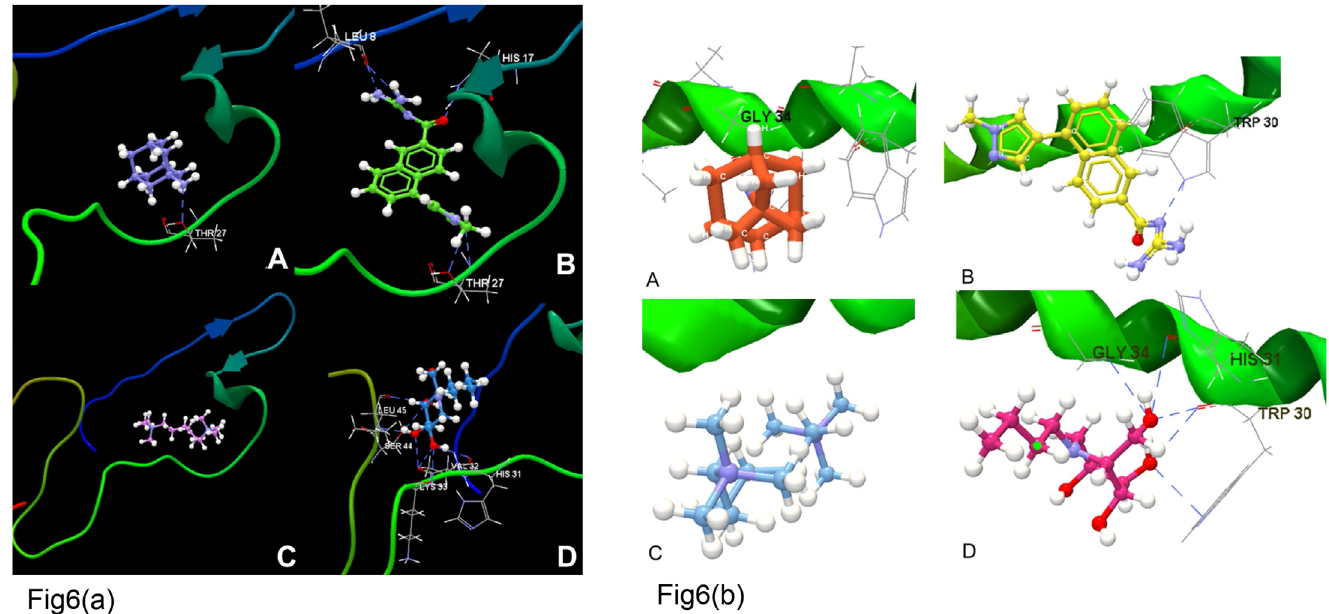
Fig 6. Computational docking study of GT3 p7 model and selected drugsMolecular binding of a set of selected ligands against GT3 p7 model (a) Amantadine, (b) BIT225, (c) Hexamethylene chloride, and (d) N-butyl-deoxynojirimycin. The Hydrogen bonds have been shown as blue dashed lines. Molecular interactions of GT4 p7 model (shown as green ribbon) with different ligands such as (a) Amantadine, (b) BIT225, (c) Hexamethylene chloride, and (d) N-butyl-deoxynojirimycin. Hydrogen bonds have been shown as blue dashed